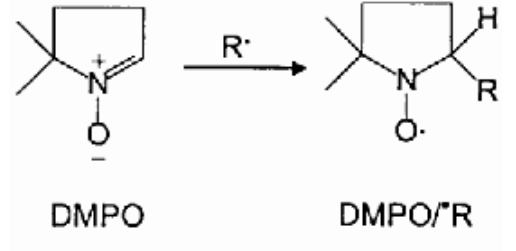
Figure 1 . Spin trapping of the radical R. with